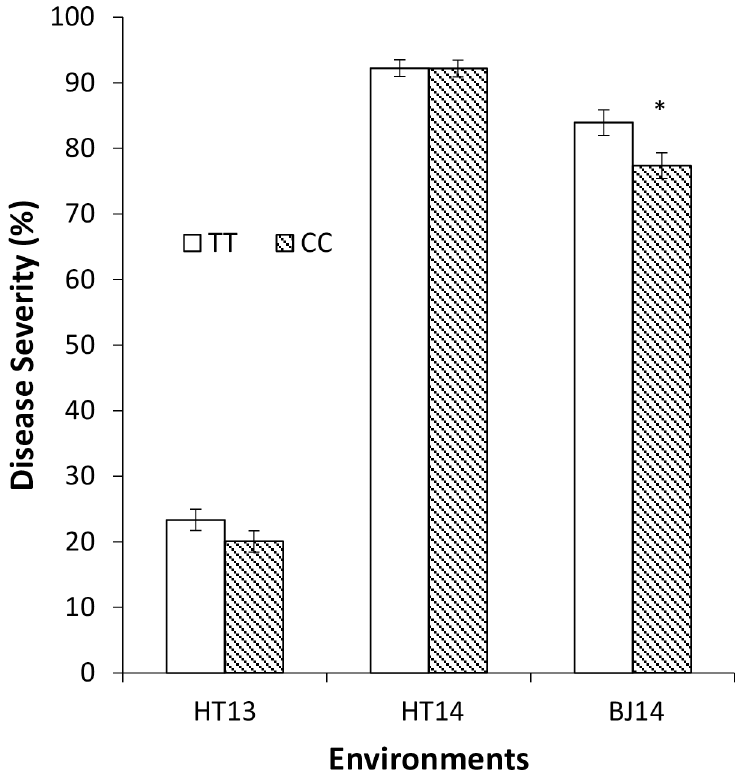
Fig 7. Mean Septoriatritici blotch disease severity by susceptible (TT) and resistant (CC) alleles for IWA3207 in 3 environments. HT13 –Holeta 2013; HT14 –Holeta 2014; BJ14 –Bekoji 2014. Each value is the mean ± standard error. Asterisk indicates that TT and CC alleles within an environment were significantly different from each other (ANOVA, P < 0.05).